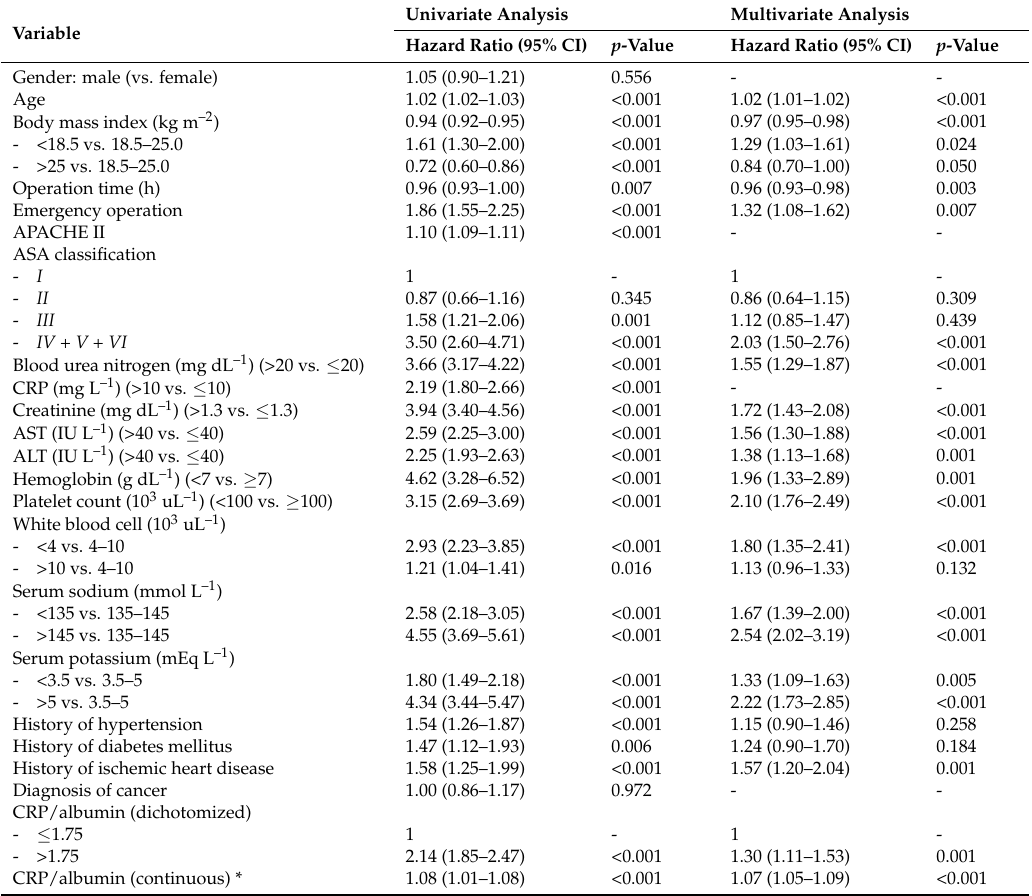
Table 2. Univariate and multivariate Cox regression analysis in relation to 30-day mortality after postoperative ICU